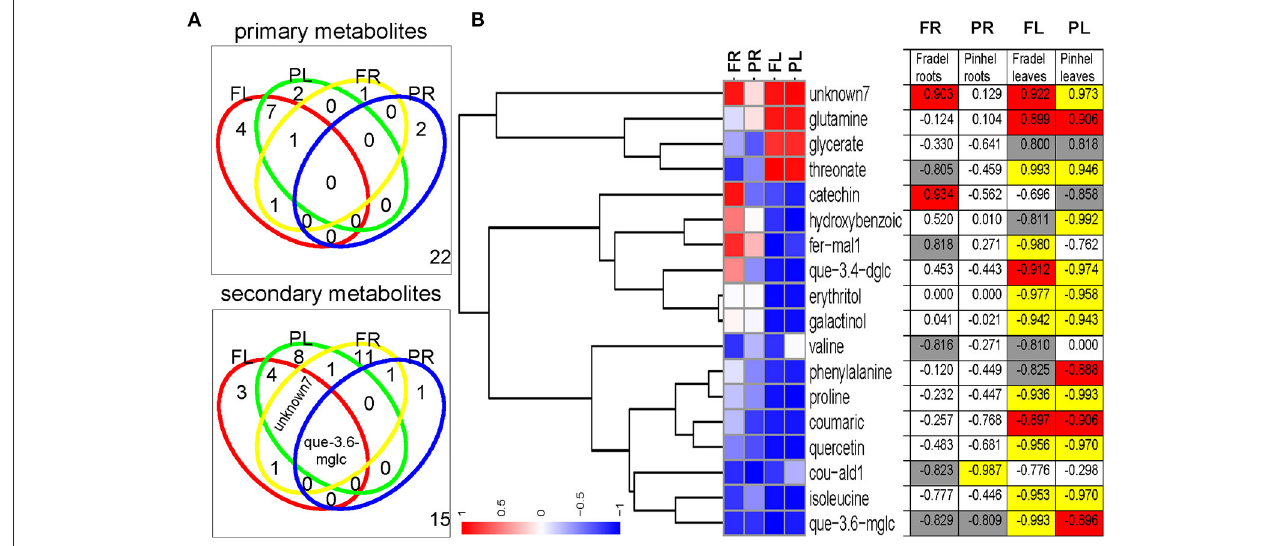
FIGURE 13 | Identification of metabolites influencing grain yield under drought stress with Pearson correlation analysis of log 2 -transformed means (full data provided in Supplementary Table 7). (A) Venn diagrams indicating the number of common and specific metabolites correlated with grain yield for each cowpea cultivar. The threshold cut-off value for the metabolite–grain yield r was set at 0.800 and the number in the lower right quadrant represents metabolites that did not meet that criterion. (B) Complete linkage tree representation of metabolites correlated with grain yield in at least two of the comparisons, using correlation distance. Significant r values are highlighted in yellow ( P < 0.01), red ( P < 0.05), and gray ( P < 0.10). fer-mal1, feruloyl-methylaldaric acid 1; que-3.4-dglc, quercetin 3- O -diglucoside-4- O -glucoside; cou-ald1, coumaroylaldaric acid 1; que-3.6-mglc, quercetin 3- O -6 ′′